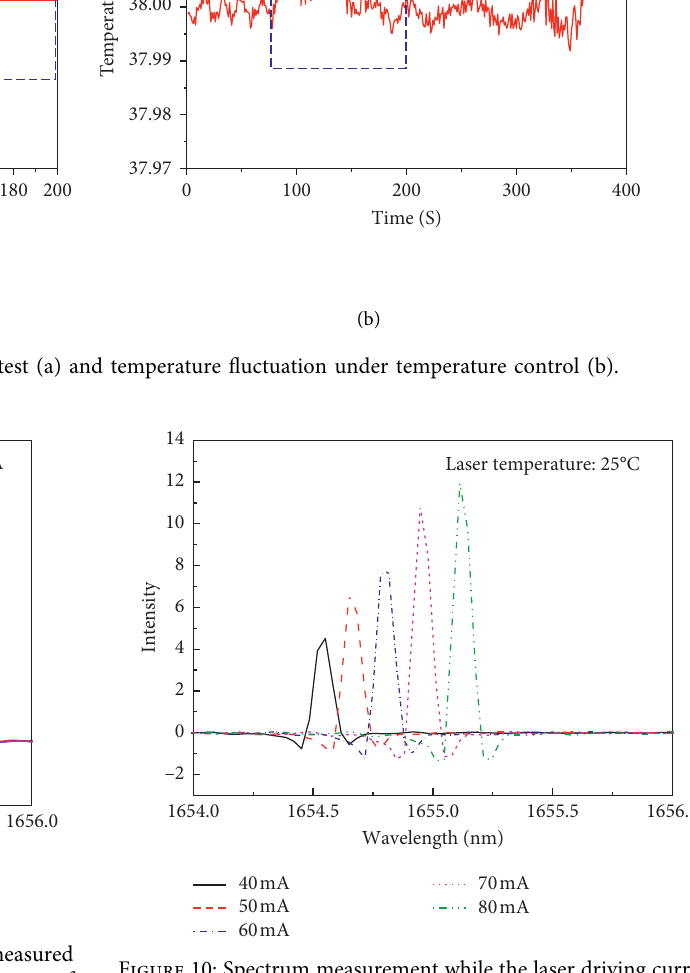
Figure 10: Spectrum measurement while the laser driving current increases from 40mA to 80mA.